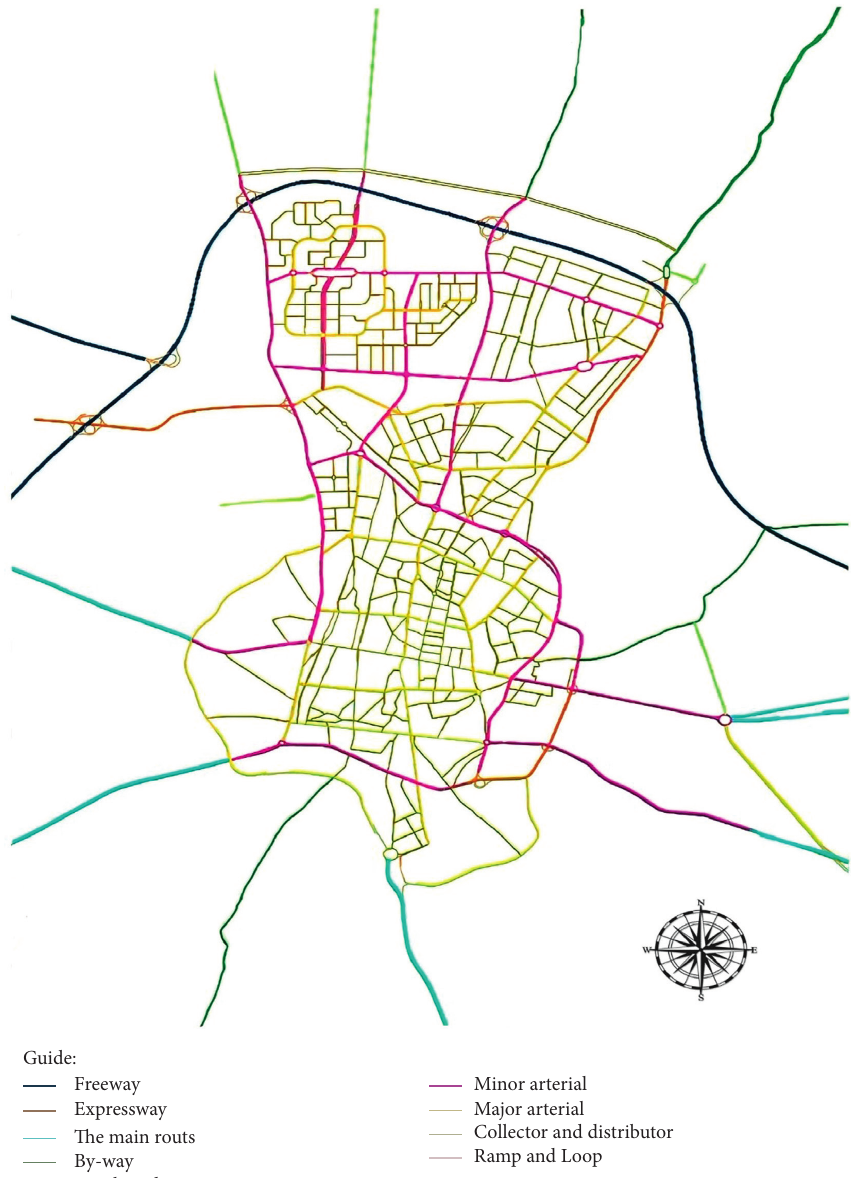
Figure 3: The road network of Qazvin